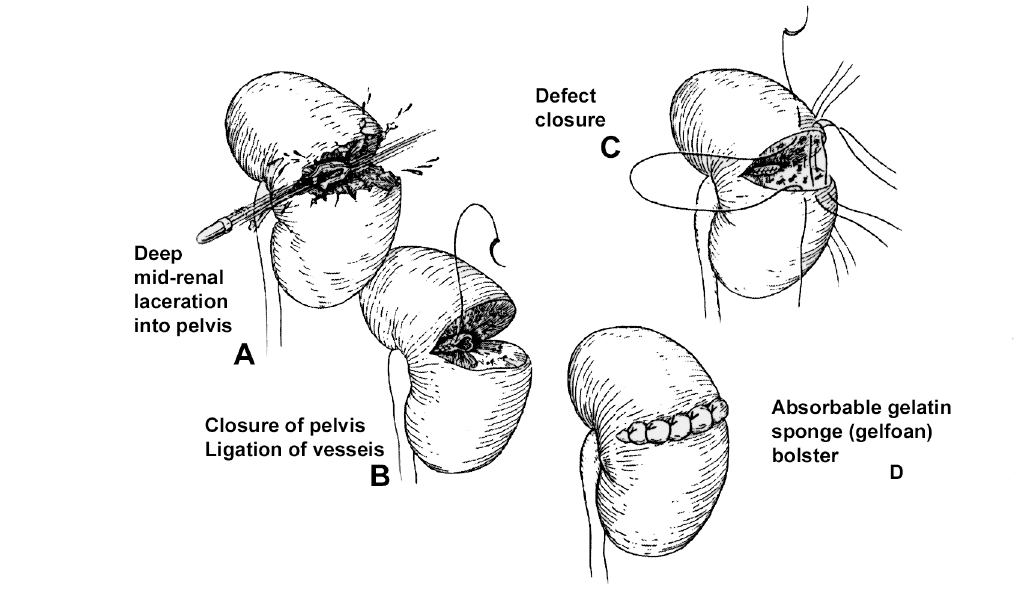
Figure 5 - Technique of renorrhaphy after midpole grade IV injury. (Reprinted with permission from: McAninch JW: Surgery for Renal Trauma. In: Novick AC, Streem SB, Pontes JE (eds.), Stewart’s Operative Urology. Baltimore, Williams & Wilkins. 1989;